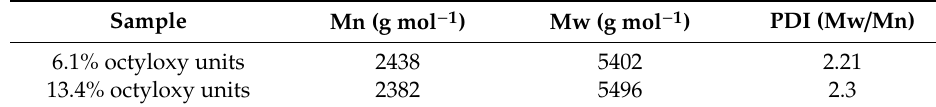
Table 1. Molar masses of copolymers prepared from benzyl chloride and 4-octylbenzyl chloride